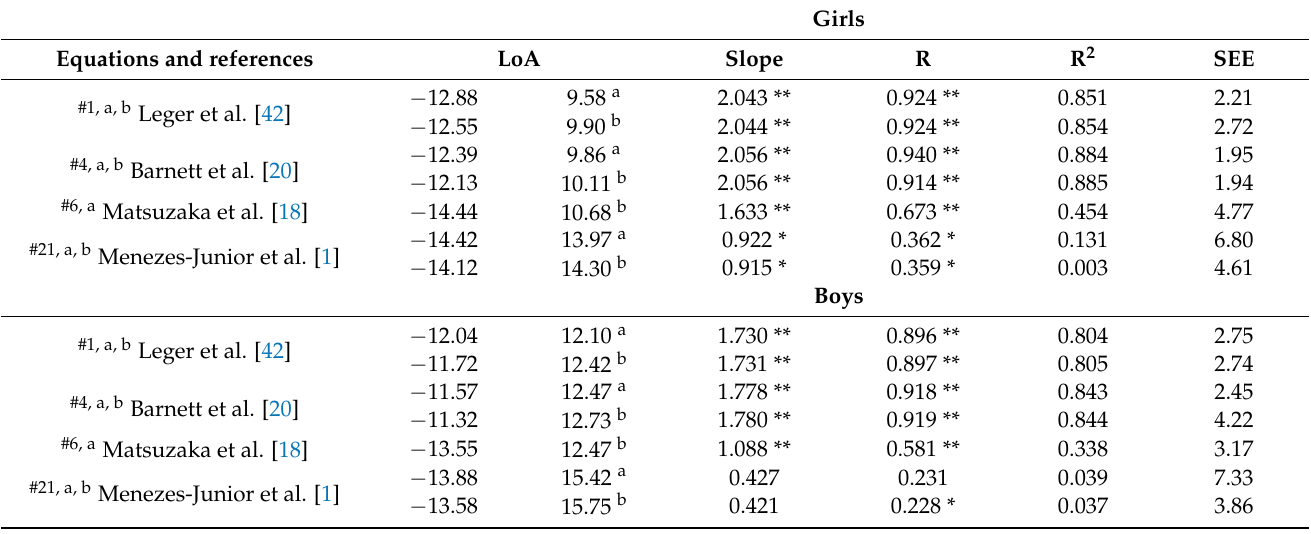
Table 7. Predictive equations using a Bland–Altman approach as compared with the measured VO 2 values (ml/kg/min) in both